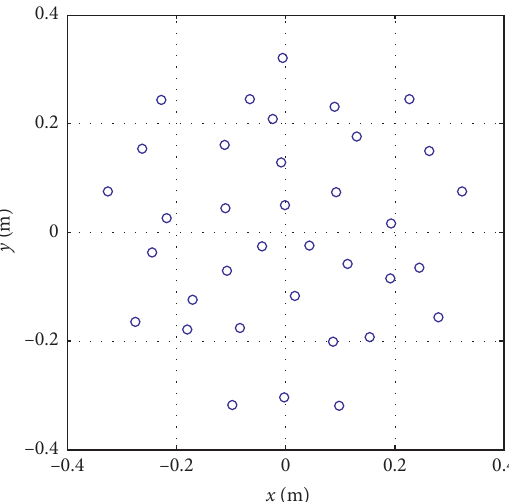
Figure 1: Array microphone distribution.